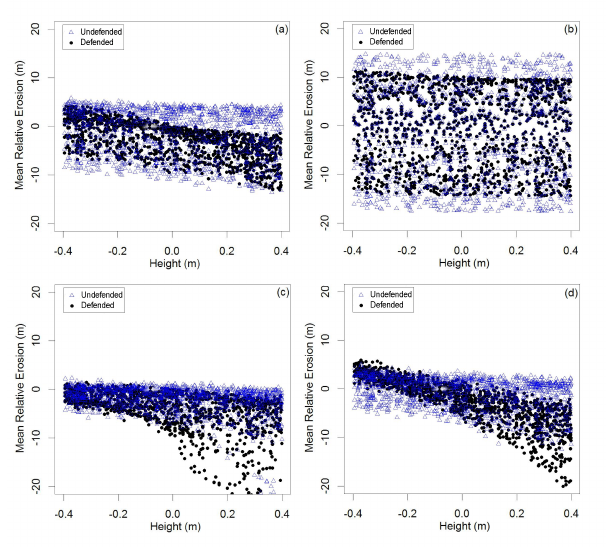
Figure 5. Perturbation in significant wave height plotted against spatially averaged mean relative erosion for (a) the entire coast, (b) the northern section (1), (c) the central section (2), (d) and the south- ern section (3). Negative values in mean relative erosion indicate a reduction in coastal erosion compared to the baseline